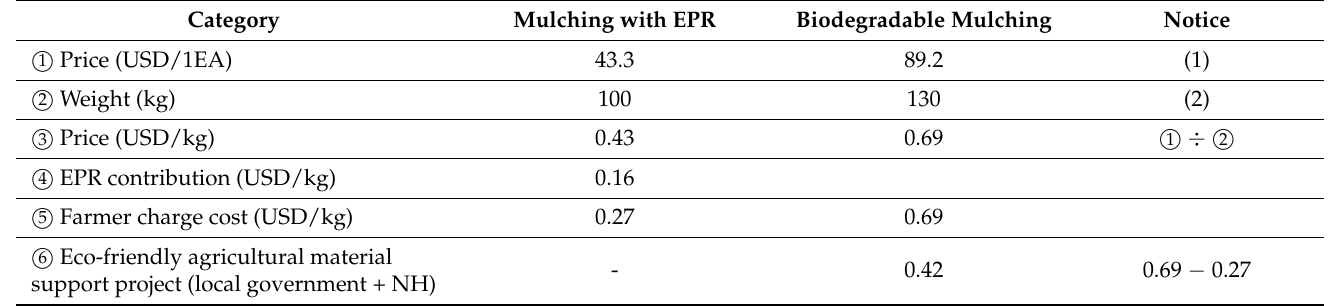
Table 3. Comparison of purchase price between general mulching and biodegradable mulching. Category Mulching with EPR Biodegradable Mulching